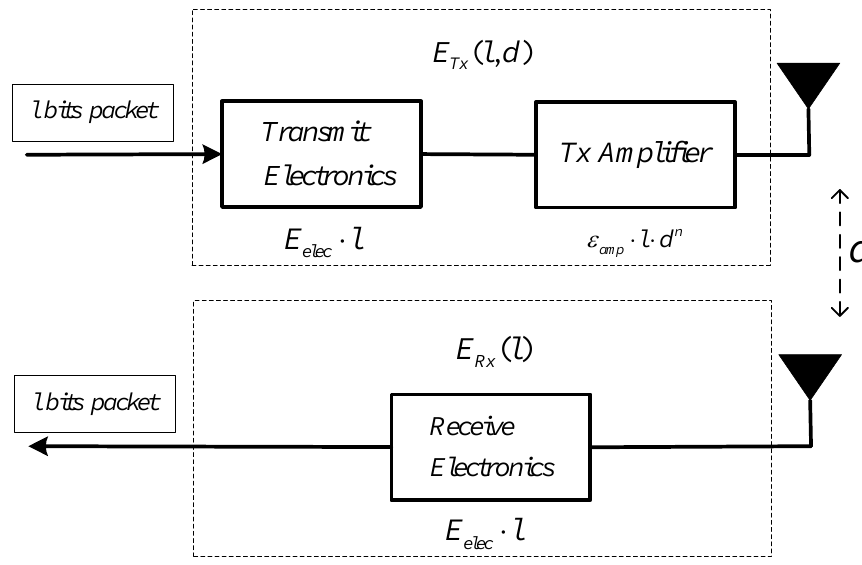
Figure 3. Energy model.